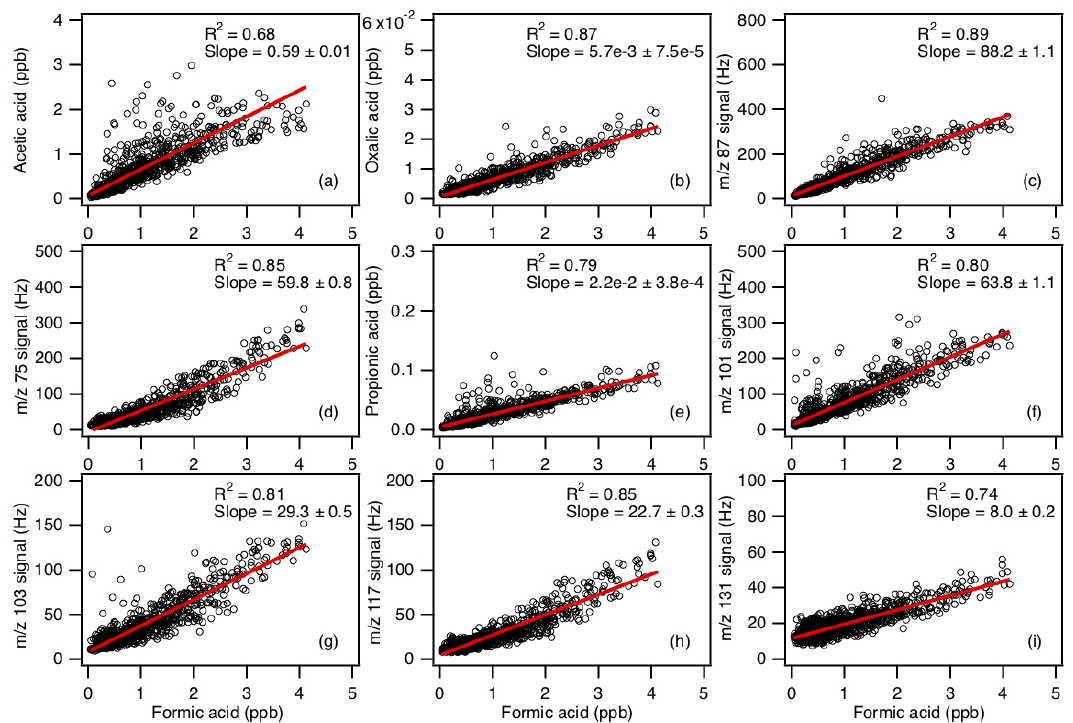
Figure 7. Scatter plots of concentrations (or ion signals) of the measured organic acids with formic acid concentration. All the data are displayed as 1h averages. Red lines shown are linear fits to the